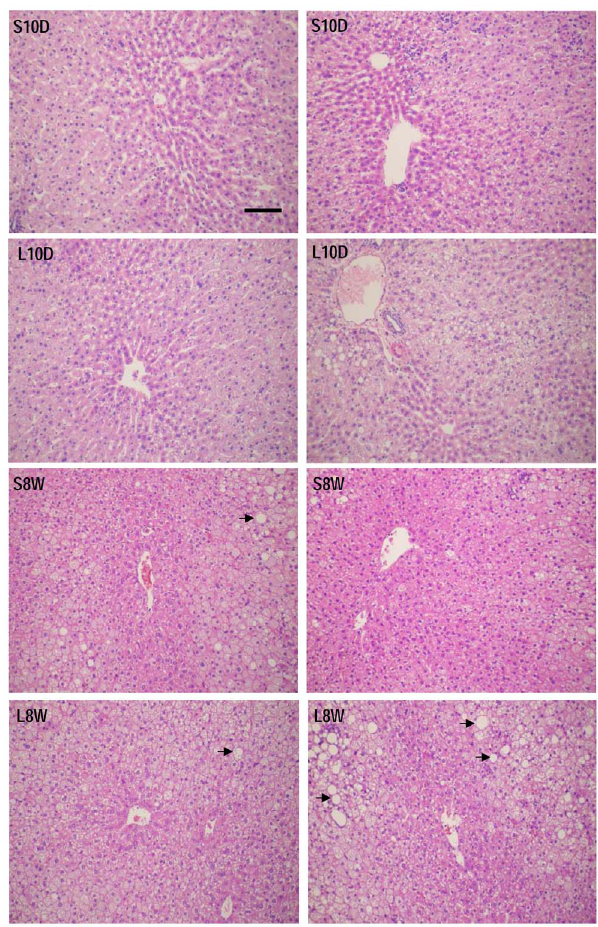
Figure 4. Hematoxylin and eosin stain of liver sections. Liver tissues were collected from lipectomized (L10D and L8W) and sham- operated (S10D and S8W) rats and stained with Hematoxylin and eosin for pathological observation. Two representative animals from each group were shown. Arrow: lipid vacuole. The scale bar represents 100 m